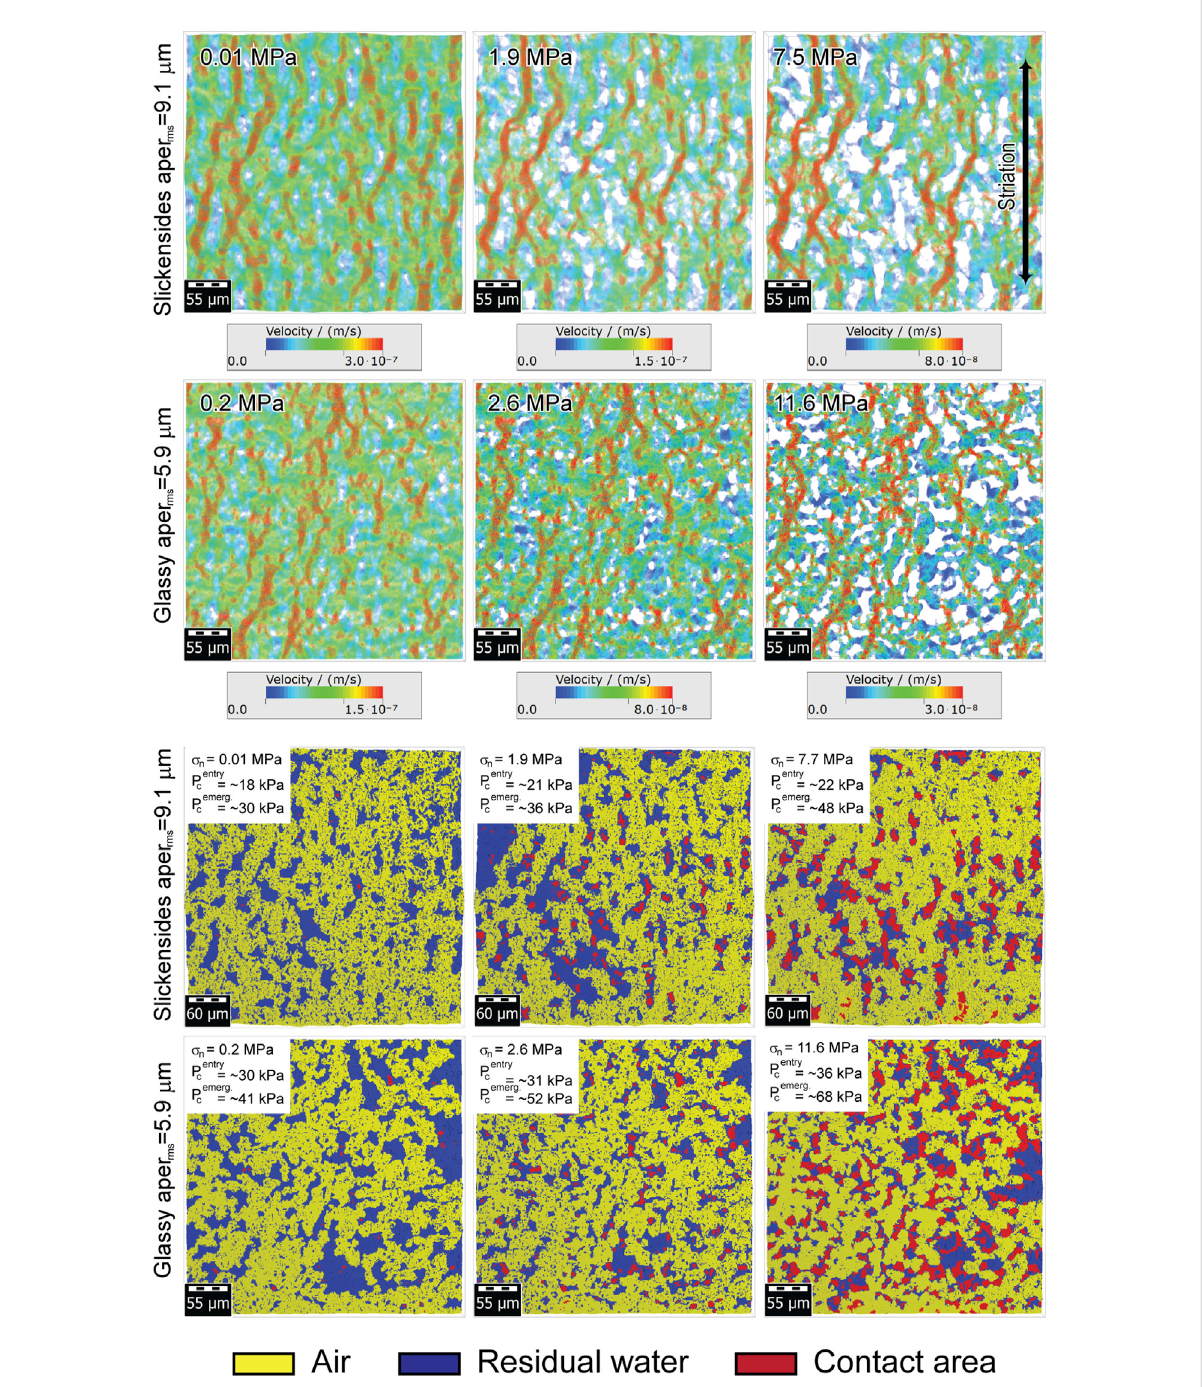
FIGURE 9 Upper two rows of images: fl ow velocity distribution for the fl ow in y -direction in slickensides of a glassy fracture type. Lower two rows of images:topviewintothefractureinteriorshowsthein fl uenceofcompressionanddifferenttypesoffracturesontheformationofcontactareas(red) and the residual water (blue) during the drainage of water from the fracture. The vertical load increases from left to